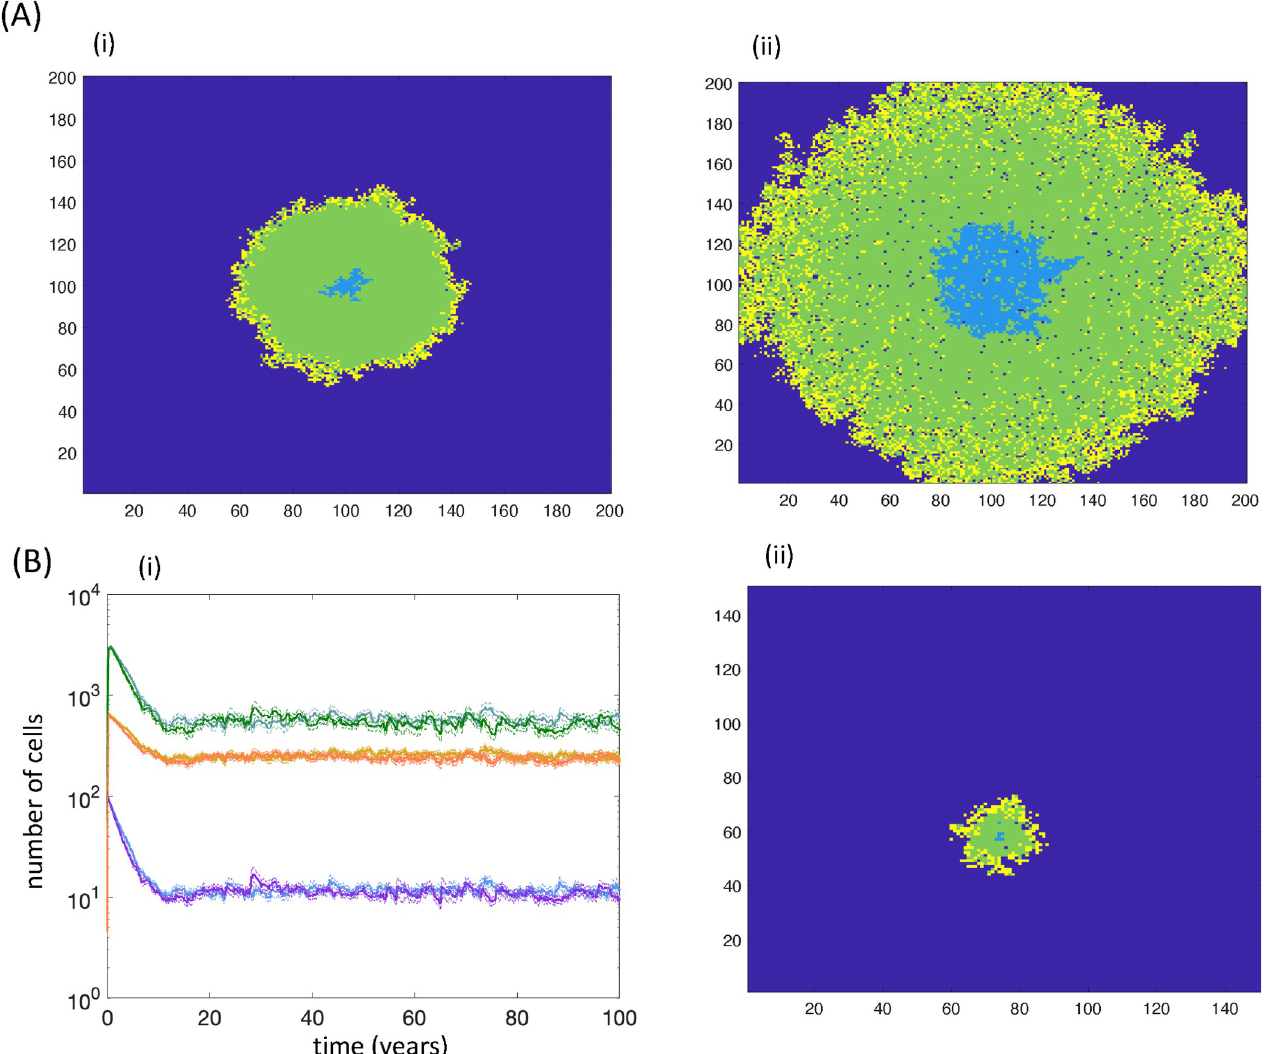
Fig 4. (A) Properties of the agent-based models with the feedforward control loop only. Dark blue represents empty space, light blue stem cells, green transit amplifying cells, and yellow terminally differentiated cells. (i) In the absence of stem and transit amplifying cell death, the cell population stops growing and converges to an equilibrium that is independent of the carrying capacity, K (not shown). The transit amplifying cells block stem cell divisions due to lack of available space, and this prevents the cluster of cells from expanding. The picture shown corresponds to the population at steady state. Parameters were as follows: P div = 4.17x10 -2 , p (0) self = 0.8, q div = 5.83x10 -2 , P Sdeath = 0, P Tdeath = 0, P Ddeath = 4.17x10 -3 , p mig = 0., c 2 = 0.833, b 2 = 8.3x10 -3 , g 2 = 0.417, h 2 = 2, n = 200. (ii) In the presence of cell death, however, this mechanism breaks down and the stem cells can continuously expand into empty space, provided by the death of transit amplifying cells. The picture represents a snap-shot during this cell expansion. Parameters were chosen as follows: P div = 4.17x10 -2 , p (0) self = 0.8, q div = 5.83x10 -2 , P Sdeath = 8.3x10 -5 , P Tdeath = 10 − 4 , P Ddeath = 4.17x10 -3 , p mig = 0., c 2 = 0.833, b 2 = 8.3x10 -3 , g 2 = 0.417, h 2 = 2, n = 200. (B) Properties of the agent-based model that contains both the feedforward and the feedback loop, and assumes the occurrence of death for all cell populations. (i) Time series, in which the system / grid size was varied, n = 100 vs n = 150. Blue and purple show stem cells for the smaller and larger grid size, respectively. Light green and dark green show TA cells, for the smaller and larger grid size, respectively. Yellow and orange show differentiated cells, for the smaller and larger grid size, respectively. The lines present the average time series over 46 iterations of the simulation, and the dashed lines represent the average plus minus standard errors. The simulation was run for 100 years to show that this mechanism can in principle maintain tissue homeostasis for long human life-spans (in the absence of any mutations that might allow cell growth) (ii) A snapshot of the spatial configuration of cells at a specific time point during steady state. Parameters were chosen as follows. P div = 4.17x10 -2 , p (0) self = 0.8, q div = 5.83x10 -2 , P Sdeath = 8.3x10 -5 , P Tdeath = 10 − 4 , P Ddeath = 4.17x10 -3 , p mig = 0., c = 8.33, b = 8.33x10 -2 , g = 0, h = 6.0x10 -2 , c 2 = 8.33, b 2 = 8.33x10 -2 , g 2 = 3.33, h 2 = 2.5. Units of rate parameters are in hours -1 .